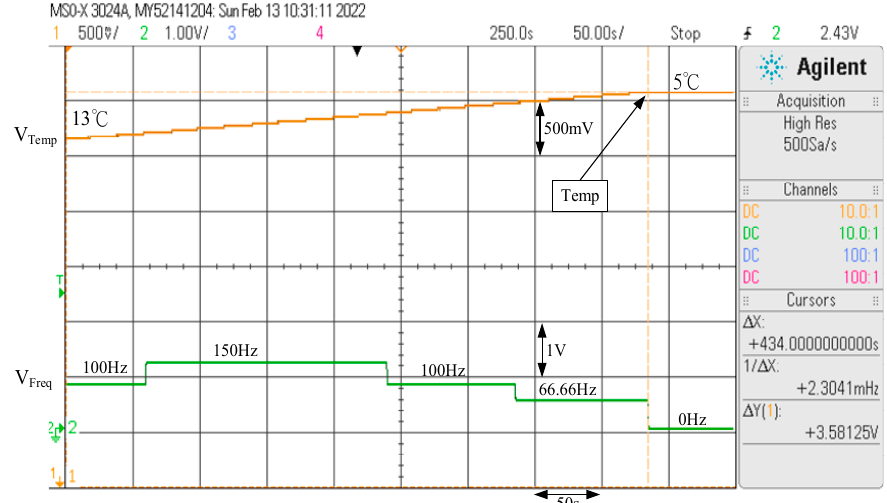
Figure 30. Response waveform of the temperature control with the conventional P-I controller (control the temperature to change from 13 °C to 5 °C).